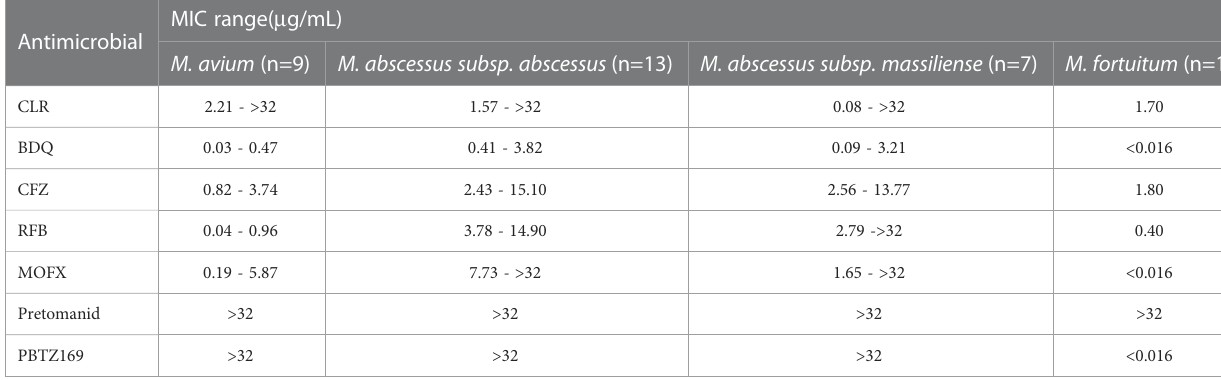
TABLE 2 MIC ranges of clinical strains of M. avium , M. abscessus and M. fortuitum for BDQ, CFZ, RFB, MOFX, PBTZ169 and Pretomanid. MIC range( m Antimicrobial